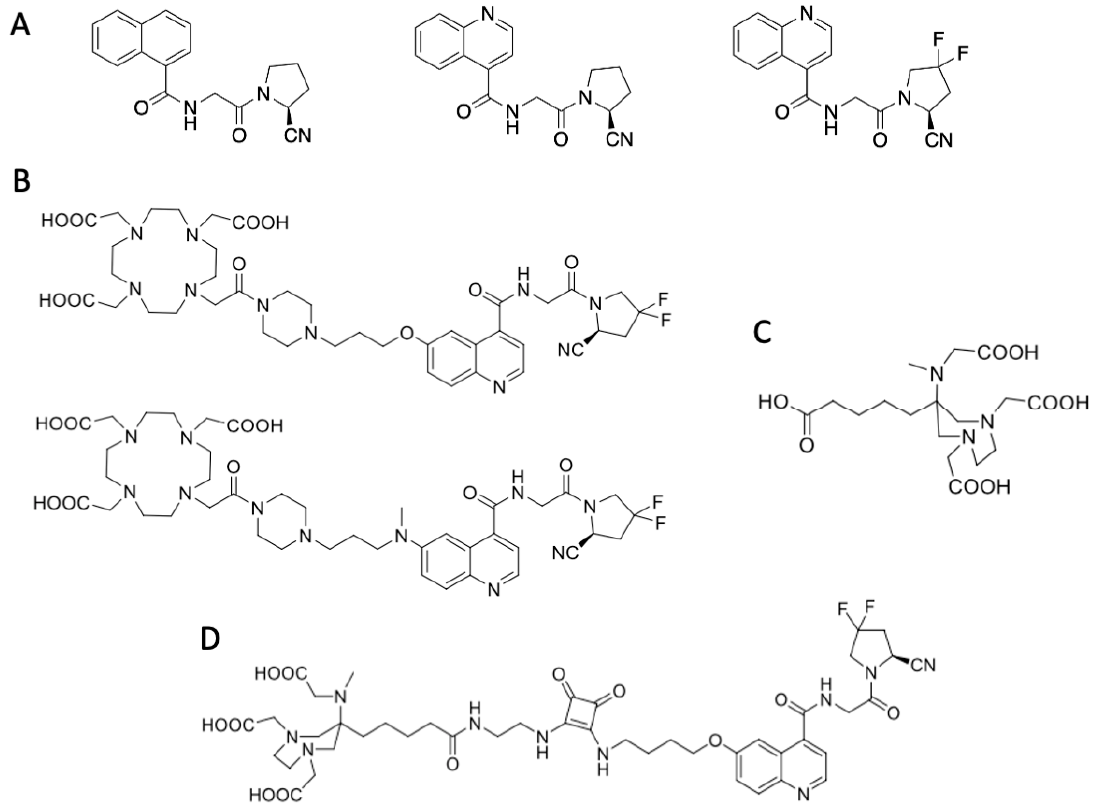
Figure 1. Schematic representation of the relevant chemical structures. ( A ): Gly-2-cyanopyrrolidine FAP inhibitors: (N-(1-naphthyl)-gly-2-cyanopyrrolidine; (4-quinolinyl)glycyl-2-cyanopyrrolidine and the quinoline-gly-2-cyano-4,4-difluoroPro-based FAPi, UAMC1110; ( B ) DOTA-conjugated FAPI conjugates FAPI-04 (top) and FAPI-46 (bottom); ( C ) DATA 5m ( D ) DATA 5m . SA.FAPi .